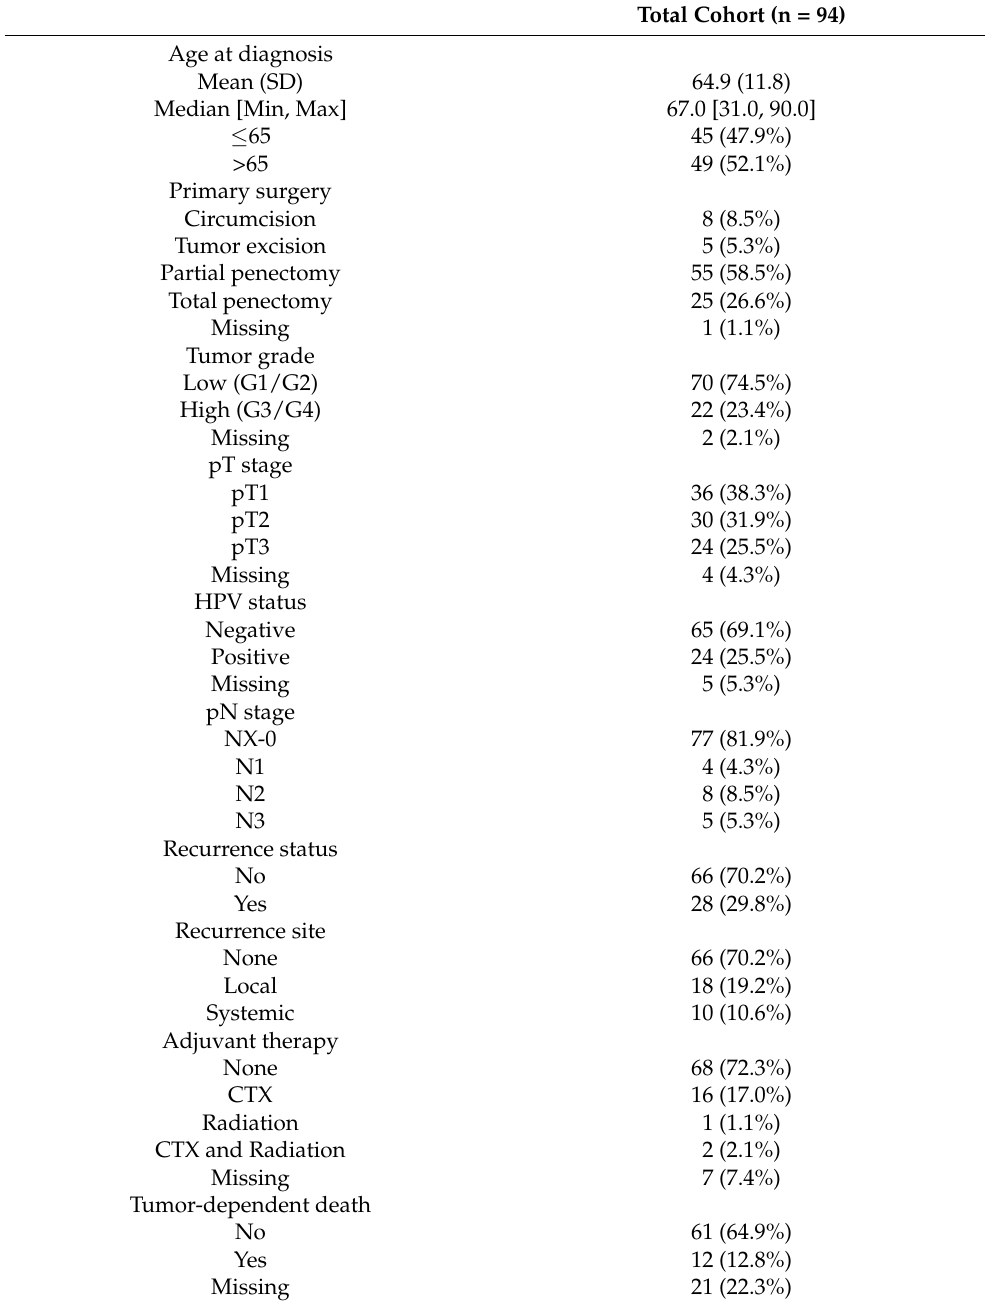
Table 1. Clinicopathological features of